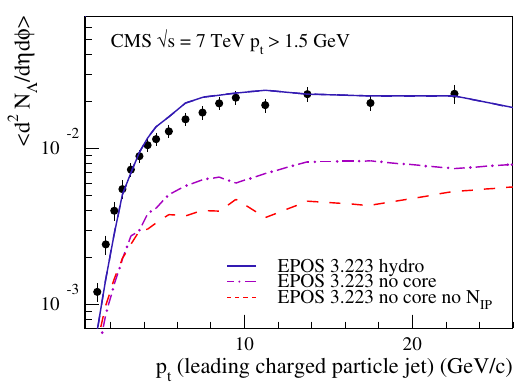
Figure 4. CMS measurement [17] of the number of Λ particles with p t ≥ 1 . 5 GeV / c produced in the underlying event, i.e. a re- gion of 60 ◦ ≤ | ∆ φ | ≤ 120 ◦ around the leading particle as a func- tion of the transverse momentum of the leading charged-particle jet. E pos 3.223 simulations are shown (see text for details).